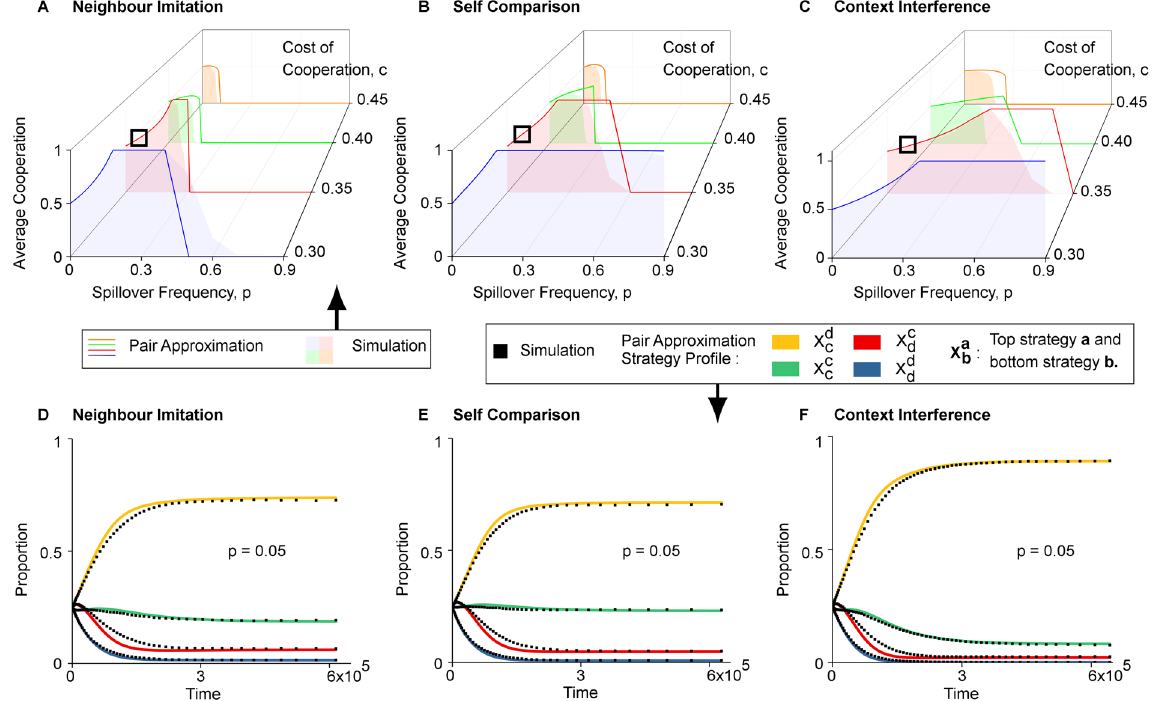
Figure 2. Double-edged effects of spillover. ( A – C ) Shows simulation and pair approximation results for average proportion of cooperators for each spillover mode ( A ) neighbour imitation, ( B ) self comparison and ( C ) context interference. As shown in more details by ( D – F ), analytical and simulation results are in good agreement at low frequencies of spillover p . For some parameter combinations, a double-edge effect of spillover on cooperation reveals itself in the form of an initial increase in cooperation with p , before a subsequent decline after an optimal p . ( D – F ) presents microscopic details of strategy profile proportions associated with each spillover mode, taken from ( A – C ) at parameter combinations ( )  . Self comparison has the largest proportion of individuals cooperating on both layers (green line), while context interference produces the largest proportion of individuals cooperating on the bottom layer and defecting on the top layer (yellow line). Parameters: n = 3600, m = 4, β = 0.2, b = 1, α = 0.5. Simulations: 6 × 10 6 time steps, averaged over 100 runs. p has step size 0.01 from p = 0 to 0.4, and step size 0.1